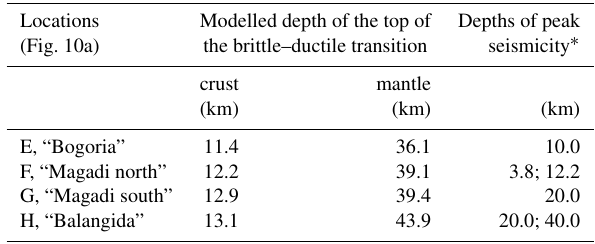
Table 5. Modelled brittle–ductile transitions and observed depths of peak